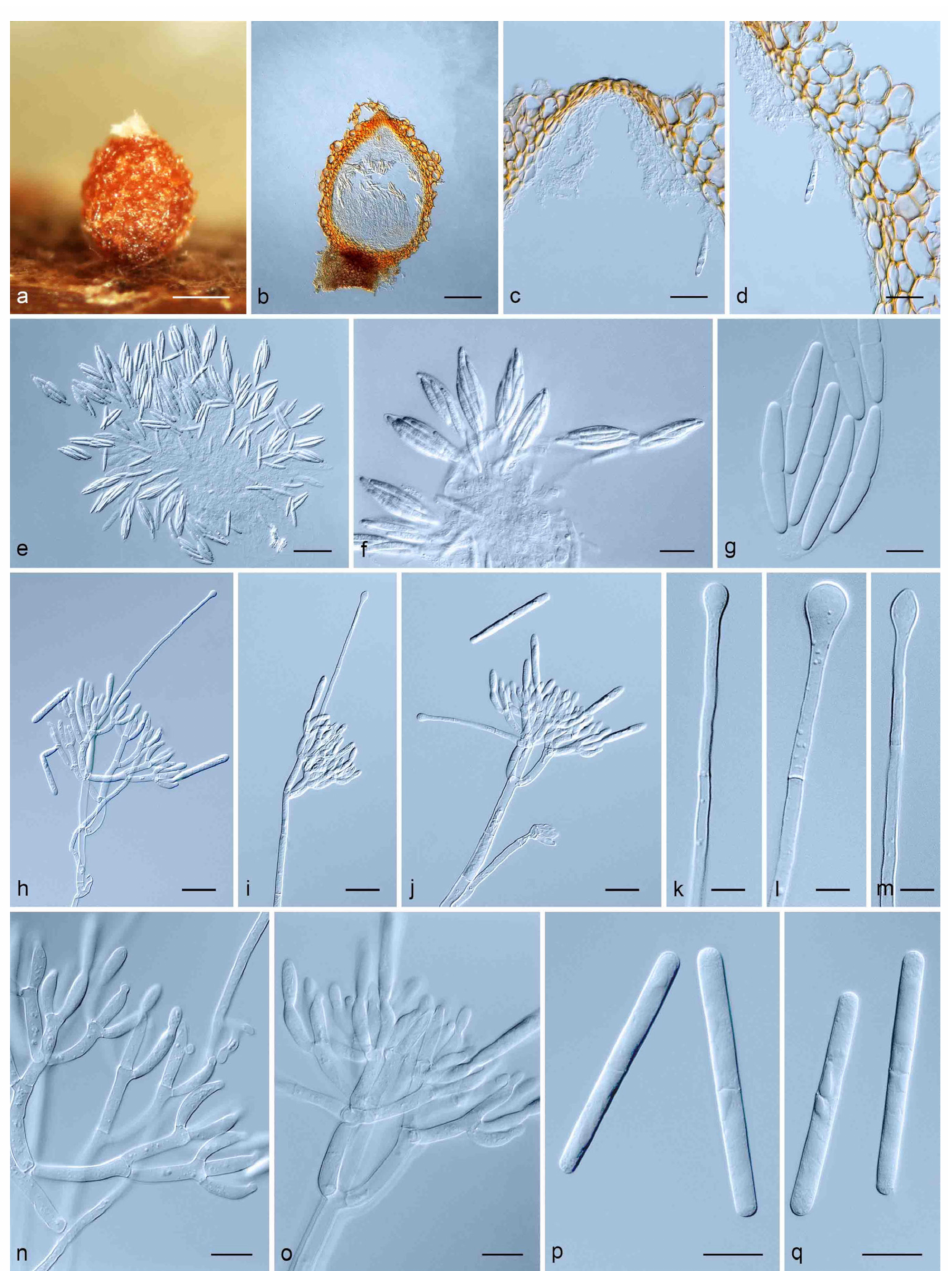
Figure A7. Calonectria aconidialis . ( a ). Perithecium; ( b ). vertical section through a perithecium; ( c ). cells around ostiolar region of perithecium; ( d ). section through lateral perithecial wall; ( e , f ). asci; ( g ). ascospores; ( h – j ). macroconidiophore; ( k – m ). obpyriform to sphaeropedunculate vesicles; ( n , o ). conidiogenous apparatus with conidiophore branches and elongate doliiform to reniform phialides; ( p , q ). macroconidia.—Scale bars: a = 200 µ m; b = 100 µ m; c, d, f and h–j = 20 µ m; e = 50 µ m; g and n–q = 10 µ m; k–m = 5 µ